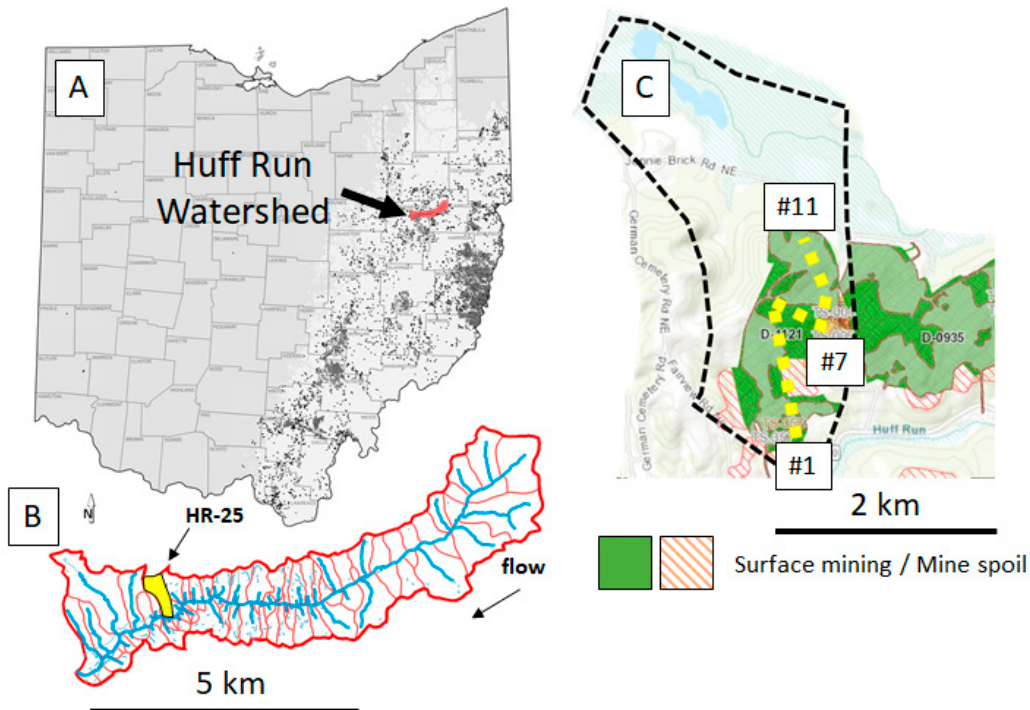
Figure 1. ( A ) Location of the Huff Run Watershed (in red), with Ohio coal counties shown in light gray and known abandoned coal mines in dark gray [30]; ( B ) watershed map [31] showing location of sub ‐ watershed HR ‐ 25 (in yellow) and stream flow direction; ( C ) spatial extent of known surface area within HR ‐ 25 (the dashed outline) affected by coal surface mining (green) and mine spoil em ‐ placement (hatched orange). The dashed yellow line indicates the transect along which the 11 sur ‐ face soil samples were collected from abandoned mine spoil piles, with positions 1, 7, and 11